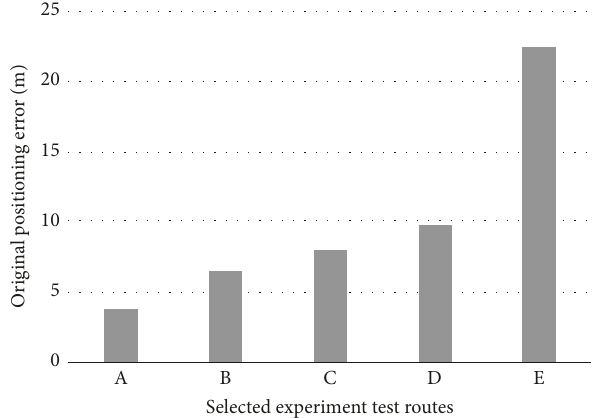
Figure 8: The raw errors disturbed by multipath effects.